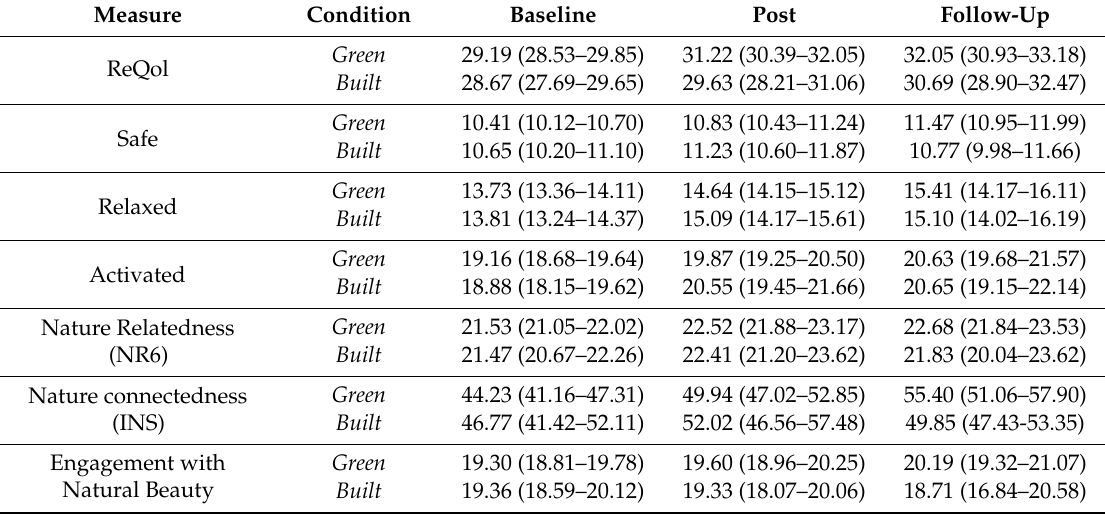
Table 2. Pre- and post-participation means and confidence intervals for the outcome